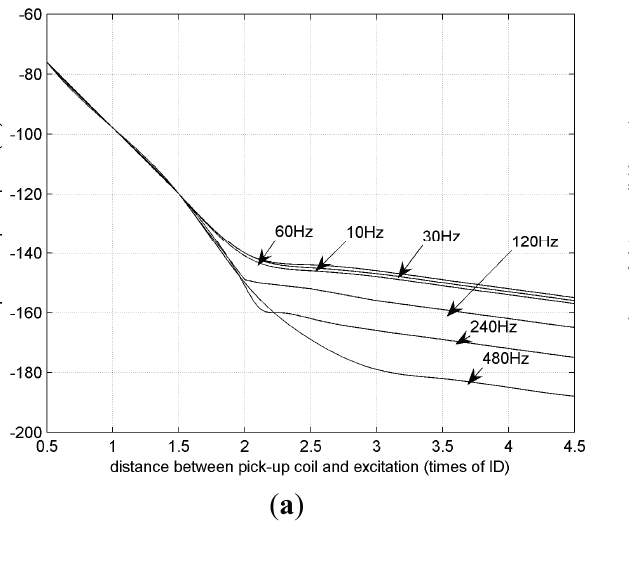
Figure 14. Characteristic curve under different frequency. ( a ) Amplitude; ( b )